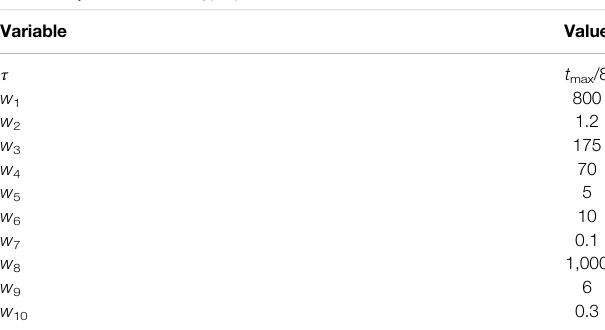
TABLE 3 | Cost function